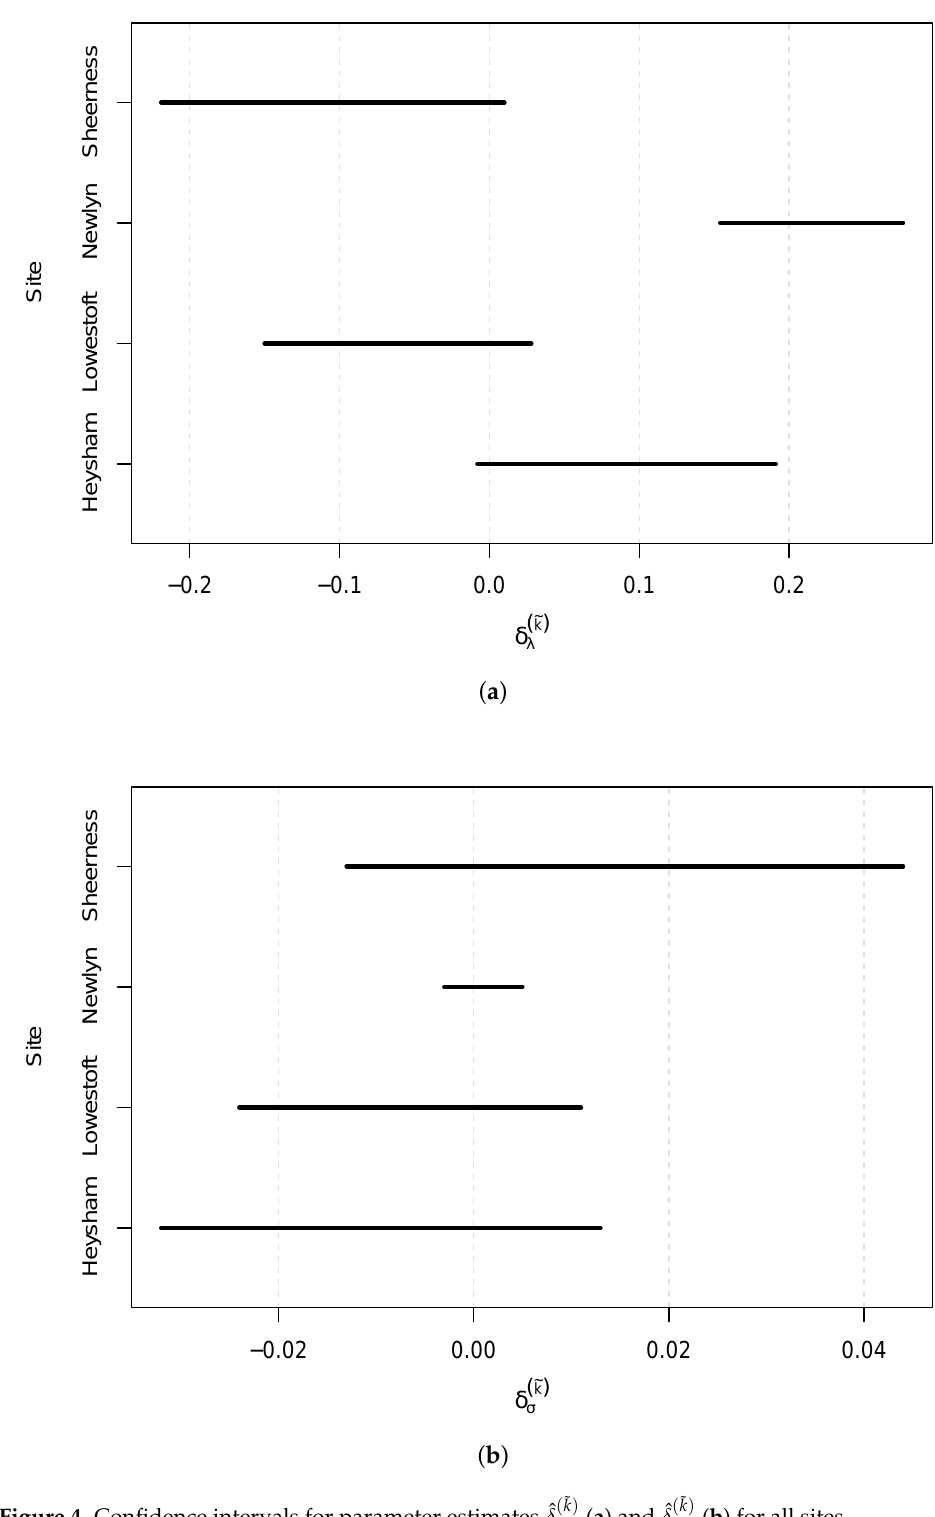
Figure 4. Confidence intervals for parameter estimates ˆ δ Models S 2 and S 4 have four additional parameters relative to Model S 0, these denote a separate trend for each season with respect to year and GMT. AIC and BIC are still minimised by Model S 0, except AIC scores for Heysham and Lowestoft, which favour Models S 2 and S 4, respectively. However, the four confidence intervals overlap at